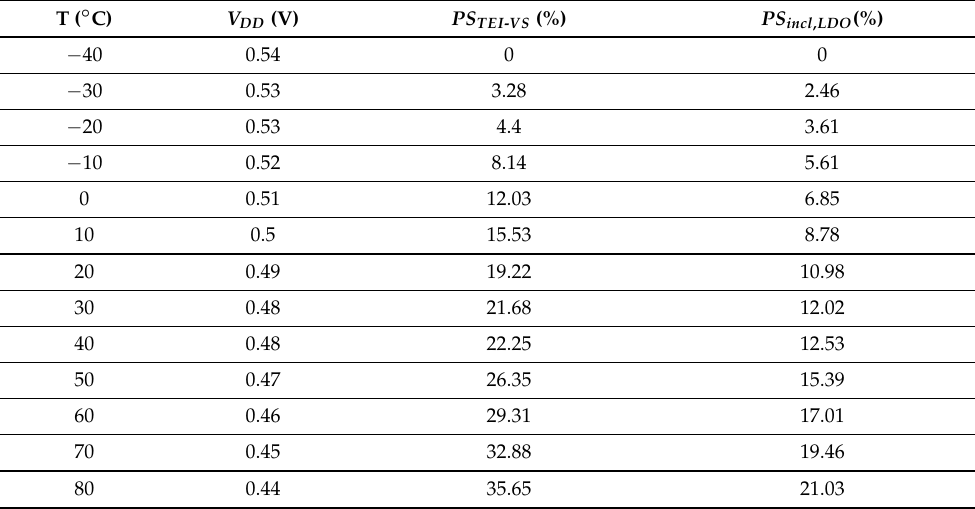
Table 1. Results of power savings when TEI-VS is applied to TIP, PS TEI - VS , and final power savings when the power consumption of LDO P LDO is included, PS incl , LDO